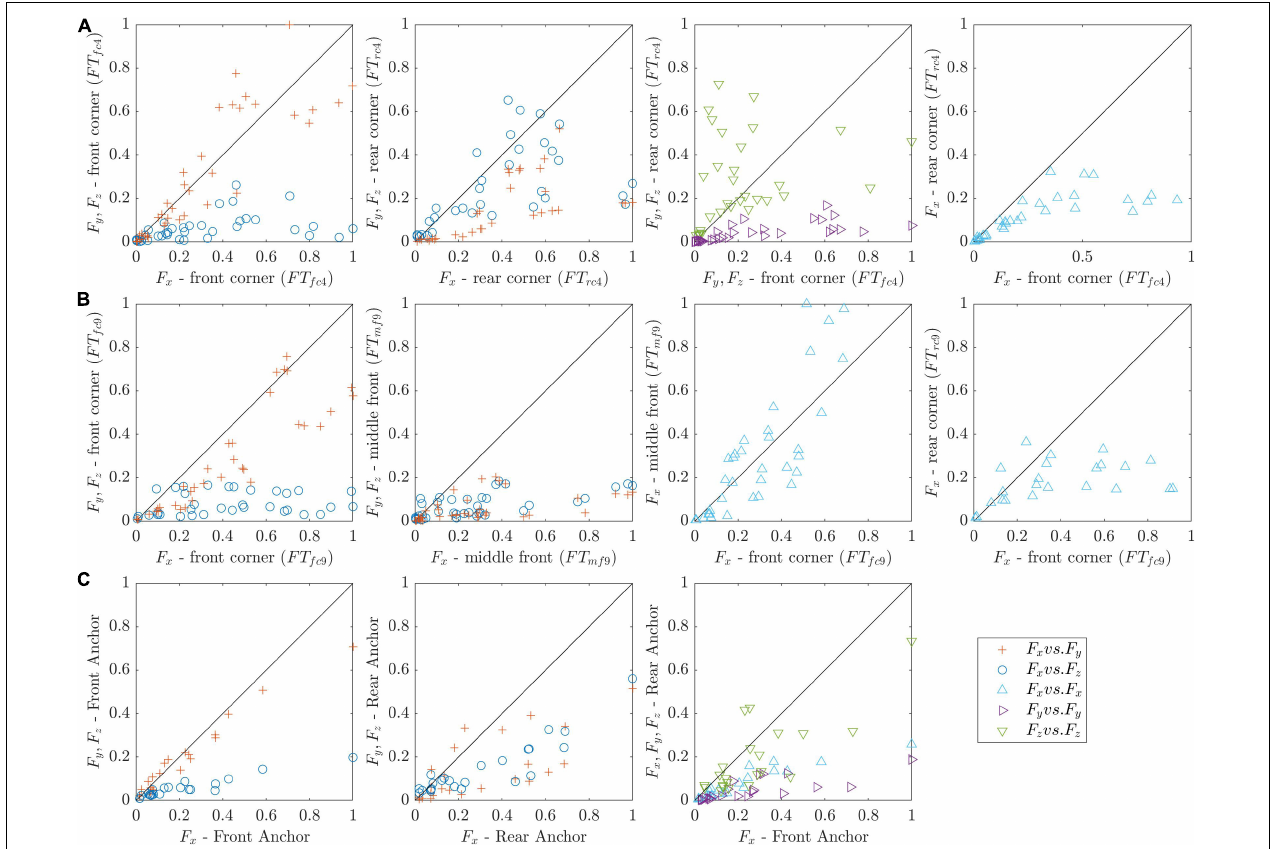
FIGURE 7 | Force component ( x , y , z ) comparison for all runs depending on anchoring position (shown in the axis label). All forces are normalized by the maximum measured force. (A) 4-anchor configuration for non-vegetated mats (CM), showing the front (FT fc 4 ) and rear anchor (FT rc 4 ) forces. (B) 9-anchor configuration (CM), comparing components in the front corner (FT fc 9 ), middle-front (FT mf 9 ) and rear corner (FT rc 9 ) anchors. (C) front and rear anchor force comparison for the vegetated mat experiments